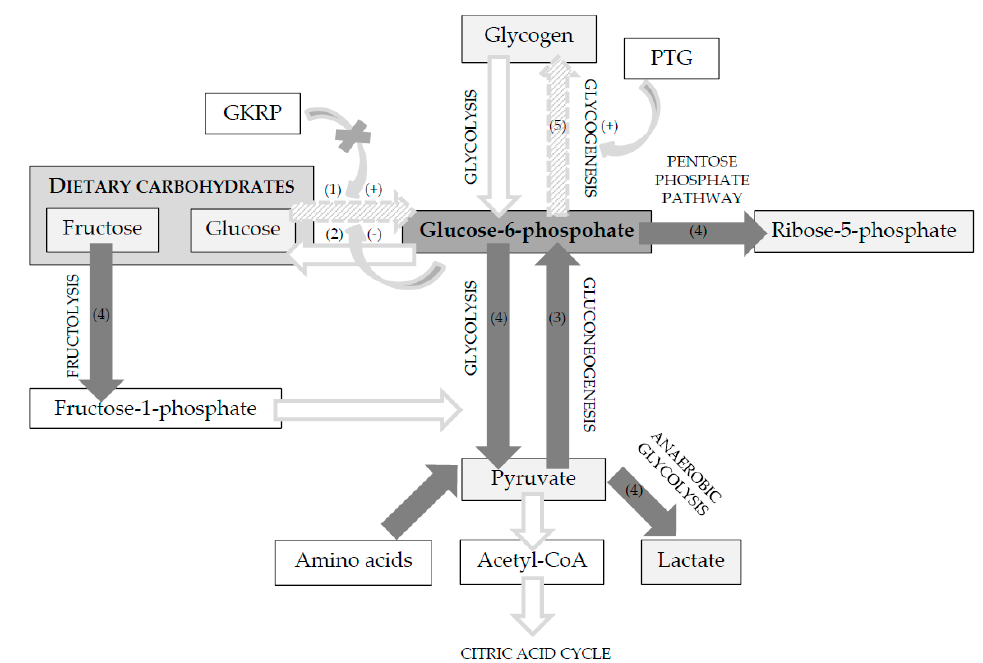
Figure 3. Glucose metabolism in feline hepatocytes. (1) Minimal to absent hepatic glucokinase